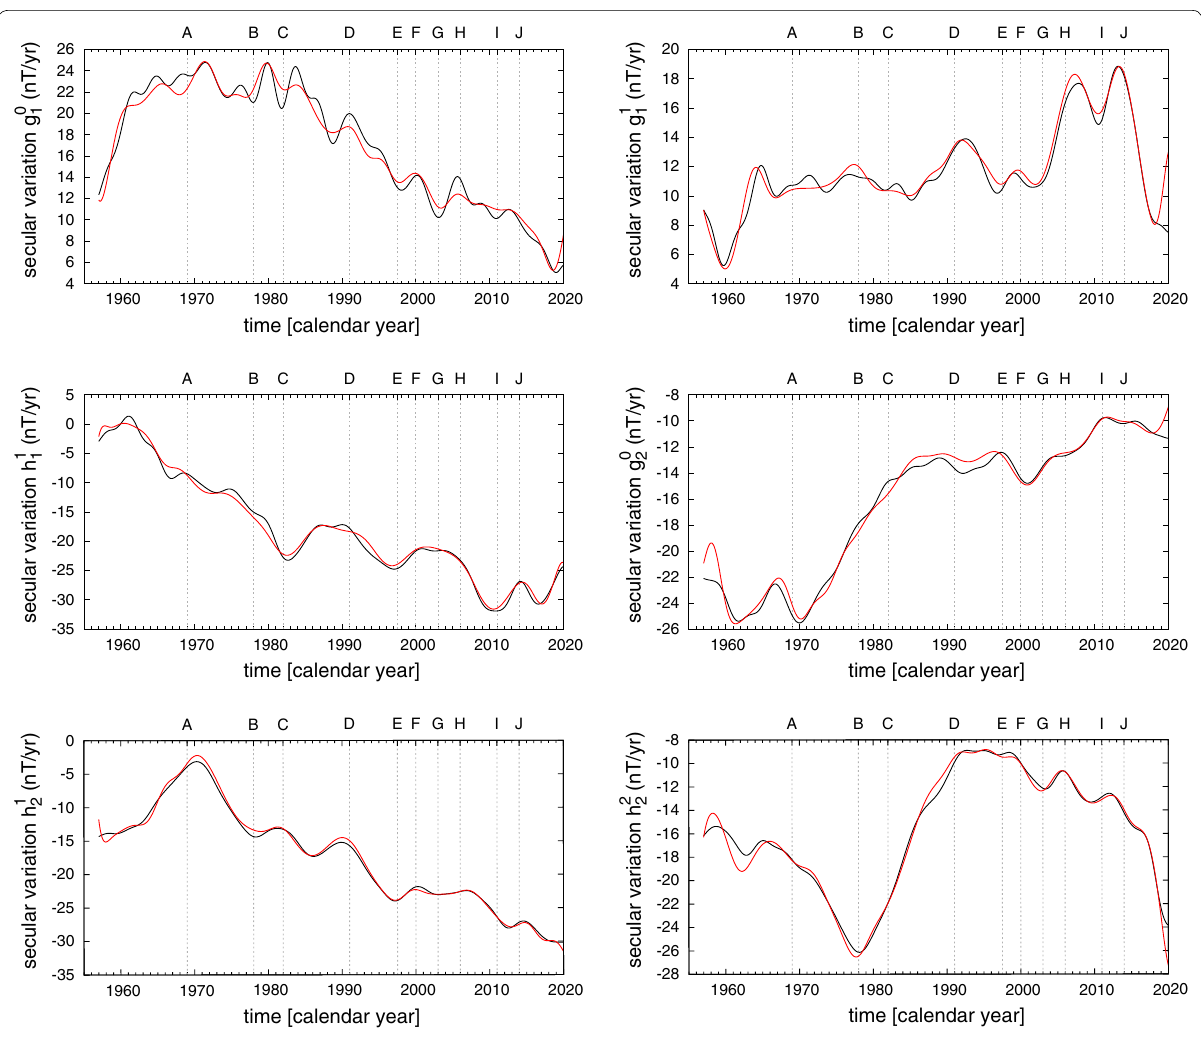
Fig. 4 Comparison of six modeled secular variation coefficients with the largest amplitude. Same colors are applied as in Fig. 3